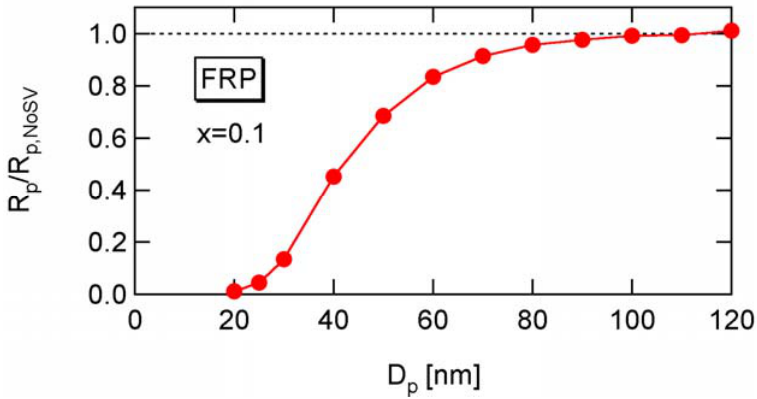
Figure 15. Ratio between the true miniemulsion rate R obtained by using the average concentrations without accounting for the statistical for conventional FRP at x = 0.1. variation effect R p,NoSV